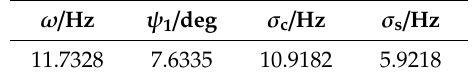
Table 1. Frequency split and relative parameters of the MOEMS-RG.